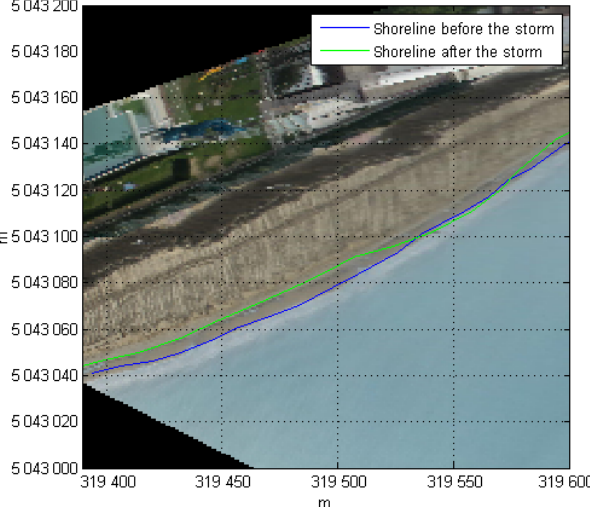
Figure 10. Detected shorelines, before and after the 9th storm, that induced a slightly enlarges of the beach.